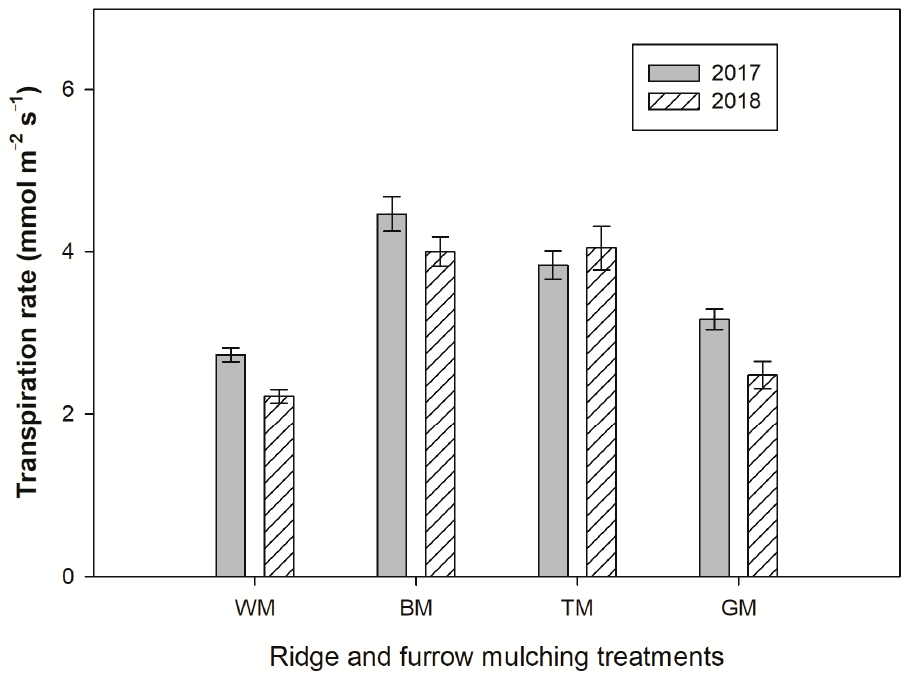
Figure 7. Influence of different ridge and furrow mulching treatments on the transpiration rate of maize in 2017 and 2018. WM = Ridge-furrow without mulch, BM = Ridge-furrow covered with black plastic mulch, TM = Ridge-furrow covered with transparent plastic mulch, GM = Ridge-furrow covered with grass mulch.